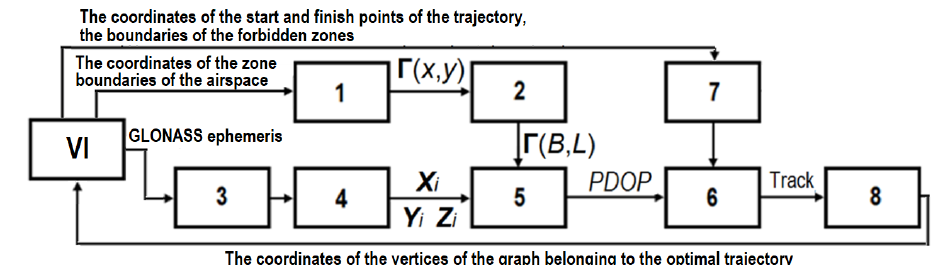
Fig. 2. Block diagram of the software